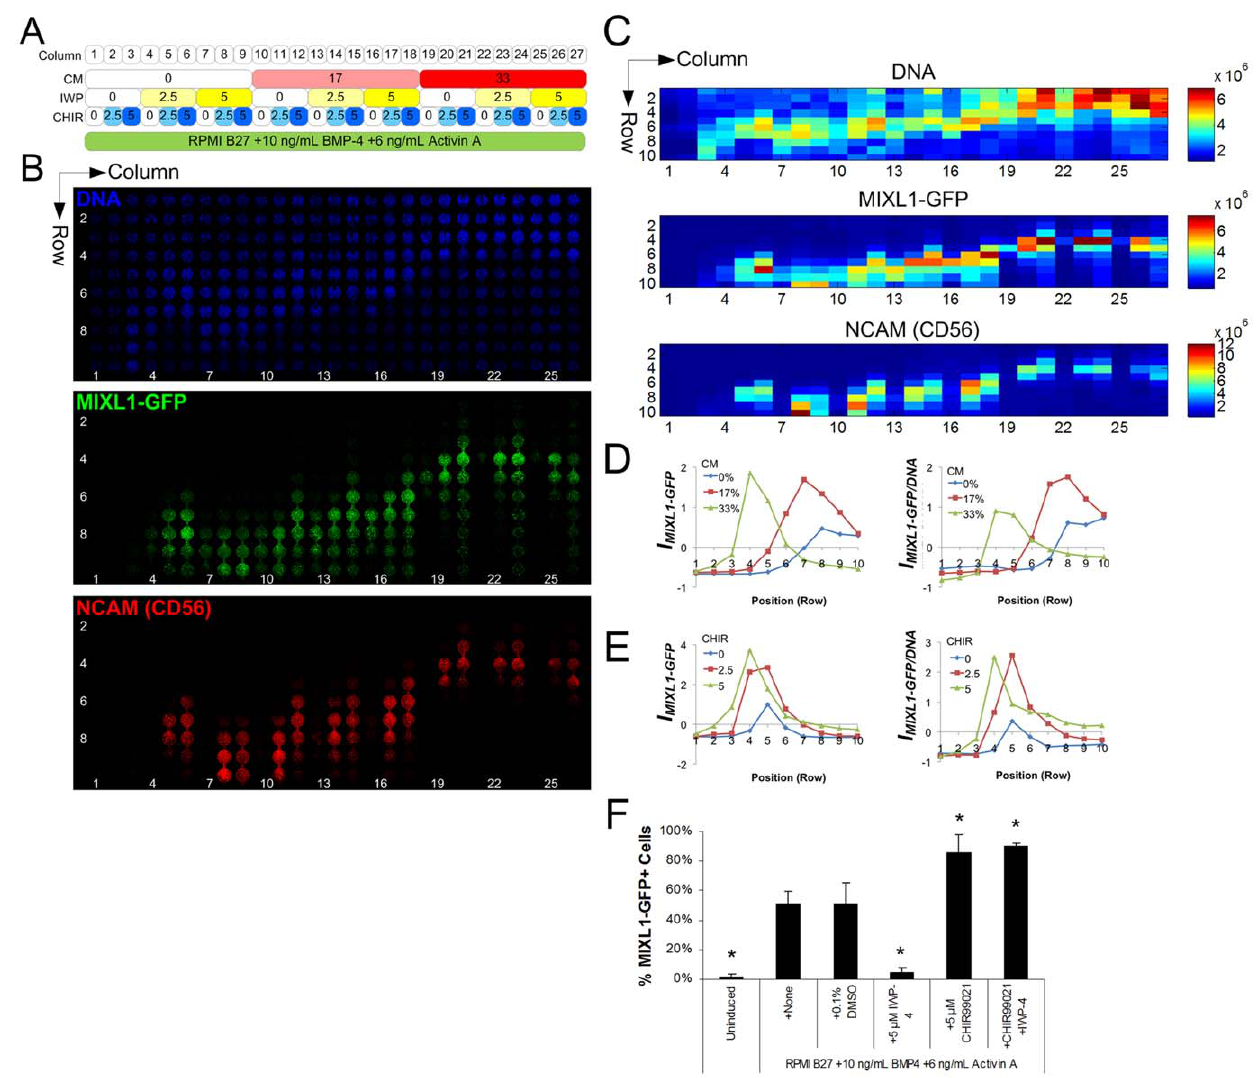
Figure 3. Confirmation and screening of paracrine factors involved in hESC mesendodermal differentiation. A Screening panel showing array conditions, corresponding to B-C. Numbers indicate concentrations of induction-conditioned and factor re-supplemented medium (CM, final % v/v), IWP-4 ( m M), and CHIR99021 (CHIR, m M). B Confocal images of HES3( MIXL1 GFP/w ) hESCs expressing GFP and co-immunostained in situ for NCAM (CD56) at experiment endpoint. Flow direction was from top to bottom. C Heat maps of total fluorescence intensities in the array (arbitrary units). D Selected interaction effect plot showing average effect magnitudes for combinations of CM and Position on expression index I MIXL1-GFP and DNA-normalised expression index I MIXL1-GFP/DNA , highlighting the shift towards earlier rows with CM treatment (legend represents CM concentration in % v/v). Full dataset, Figures S6, S7. E Traces of expression index I MIXL1-GFP and DNA-normalised expression index I MIXL1-GFP/DNA versus position coordinate for 0 (Column 19), 2.5 (Column 20), and 5 m M CHIR (Column 21) showing extended expression under CHIR treatment. F Blocking of MIXL1- GFP induction in static cultures with IWP-4, and improvement and rescue of induction with CHIR. Bars represent mean 6 SD of 4 biological replicates over 2 independent experiments. * indicates p , 0.05 relative to + None